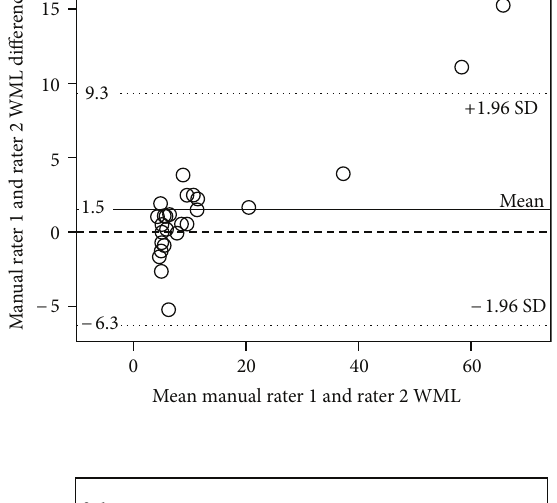
F 4: Sagittally reformatted slice from an example subject showing the common anterior intensity shi between the fourth and �h slices in the coronal 2D FLAIR